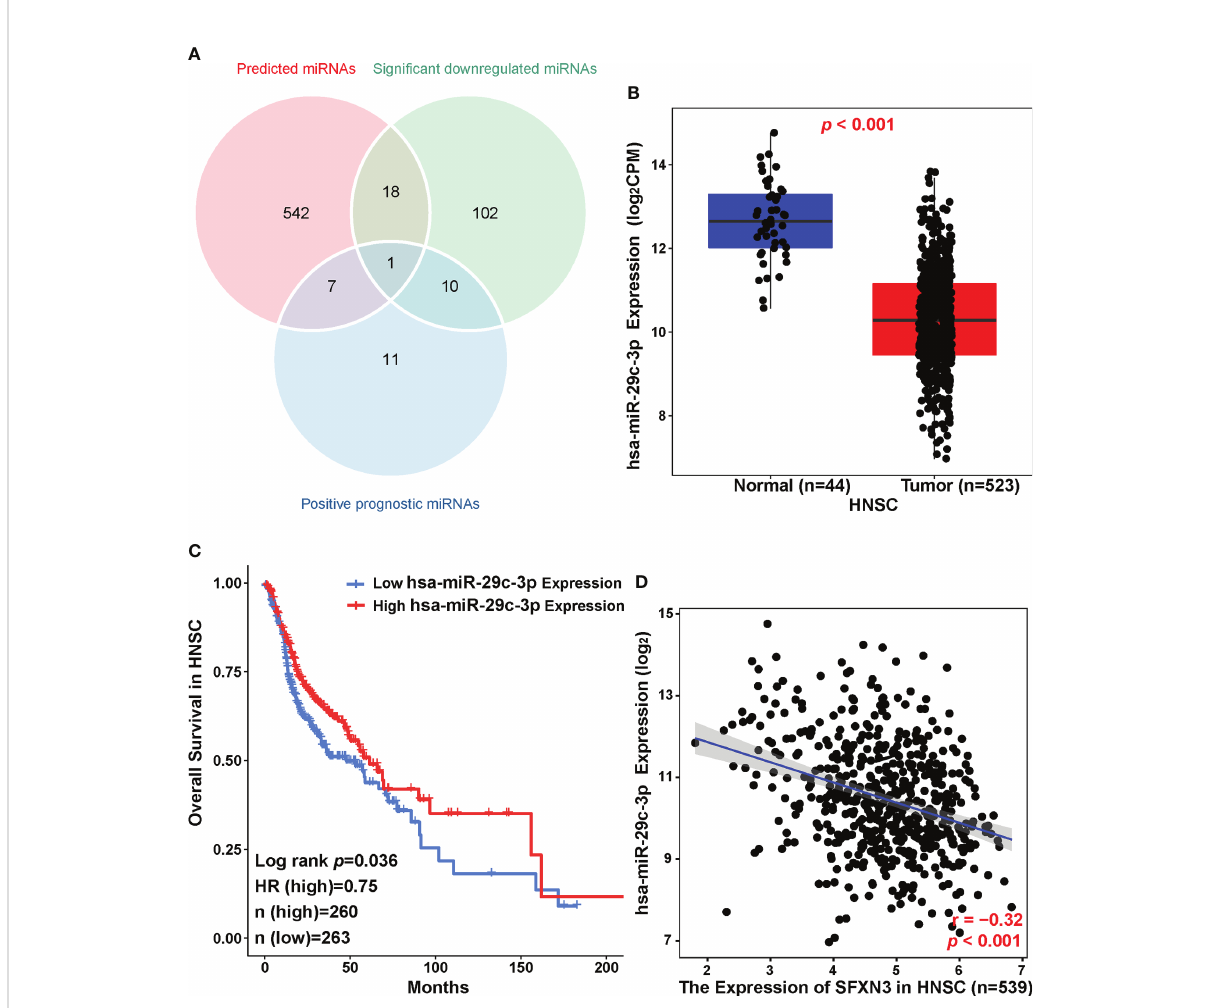
FIGURE 6 Identi fi cation of hsa-miR-29c-3p as a potential upstream miRNA of SFXN3 in HNSC. (A) Venn diagram of predicted miRNAs, downregulated miRNAs, and miRNAs related to better survival in HNSC. (B) The expression of hsa-miR-29c-3p in HNSC and control normal samples as determined using the CancerMIRNome database. (C) The prognostic value of hsa ‐ miR ‐ 29c ‐ 3p in HNSC assessed using the CancerMIRNome. (D) The expression correlation between hsa-miR-29c-3p and SFXN3 in